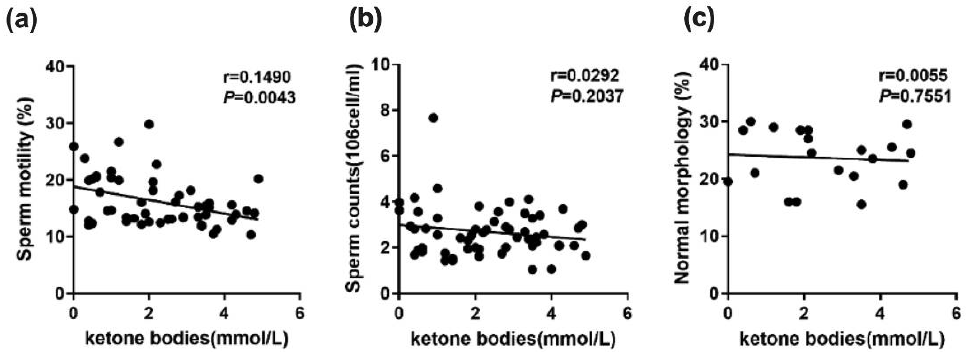
Figure 3. Correlation between ketone bodies and sperm quality parameters; ( a ) sperm motility, ( b ) sperm counts, ( c ) percentage of normal sperm morphology in male mice. n = 11–12 per group. (Pearson’s test, p < 0.05). r: spearman correlation coefficient.